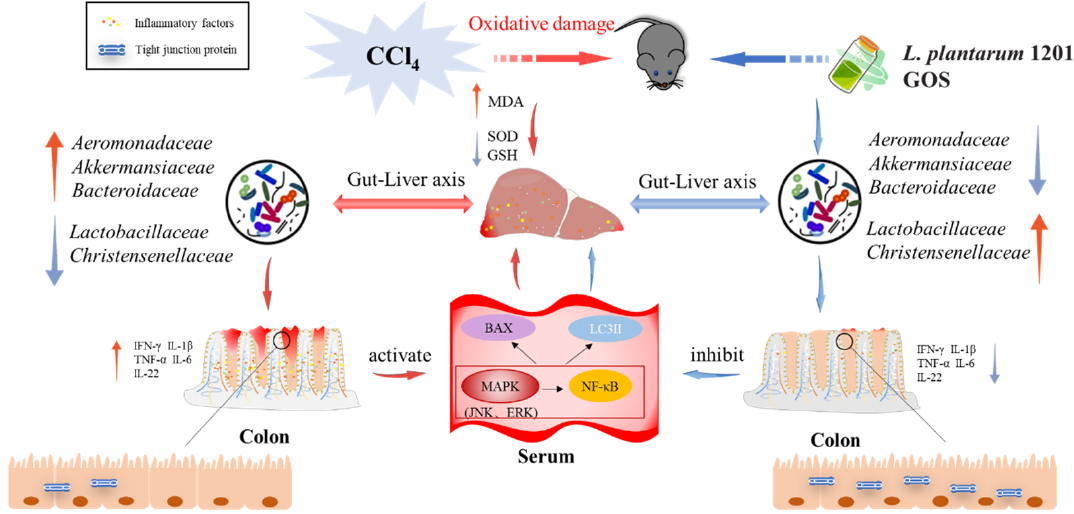
Figure 7. Schematic representation of the role of intestinal flora in the improvement of ALI through synbiotics. After intraperitoneal injection, CCl 4 damages the liver, causing oxidative damage and inflammation of the liver; then it affects the balance of intestinal flora through the liver–gut axis, causing intestinal inflammation and damage, and intestinal damage in turn aggravates liver damage, causing autophagy and apoptosis. However, synbiotics act directly on the intestinal flora, relieving intestinal inflammation, inhibiting the autophagy and apoptosis pathways, and protect ing the liver from inflammation and oxidative damage.